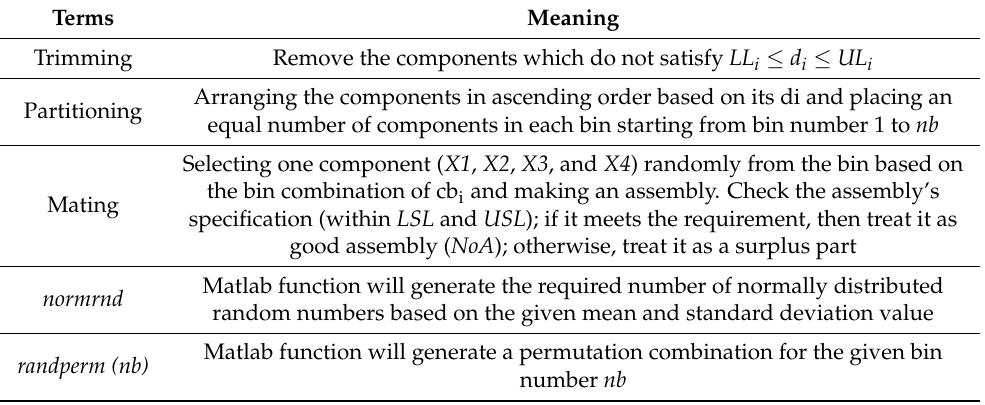
Table 5. Technical terms and their meanings.